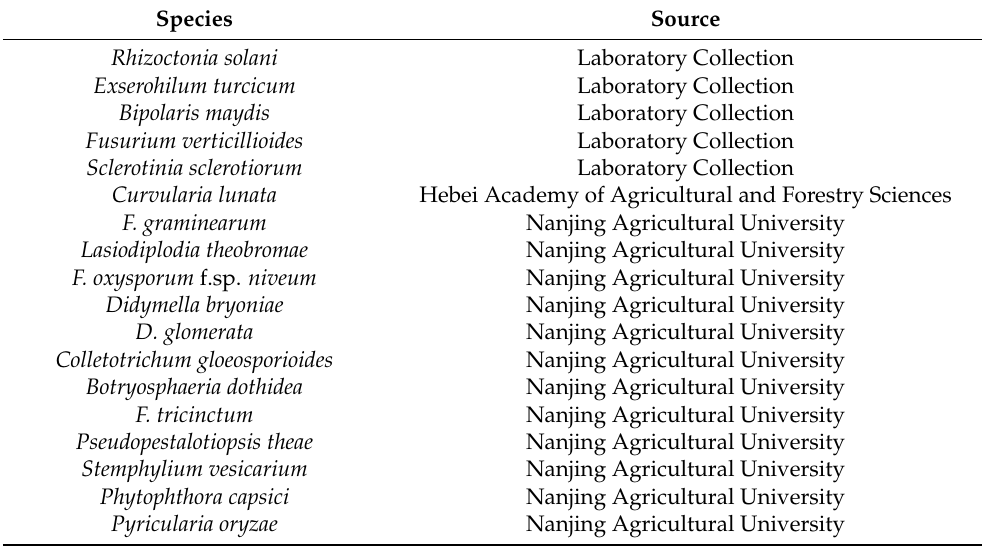
Table 1. Pathogenic fungi used in this study. Species